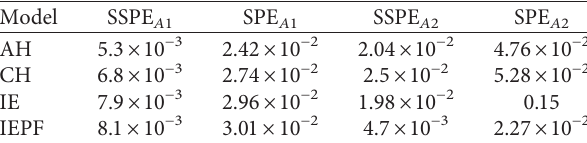
Table 4: Stability of each model for example 1.